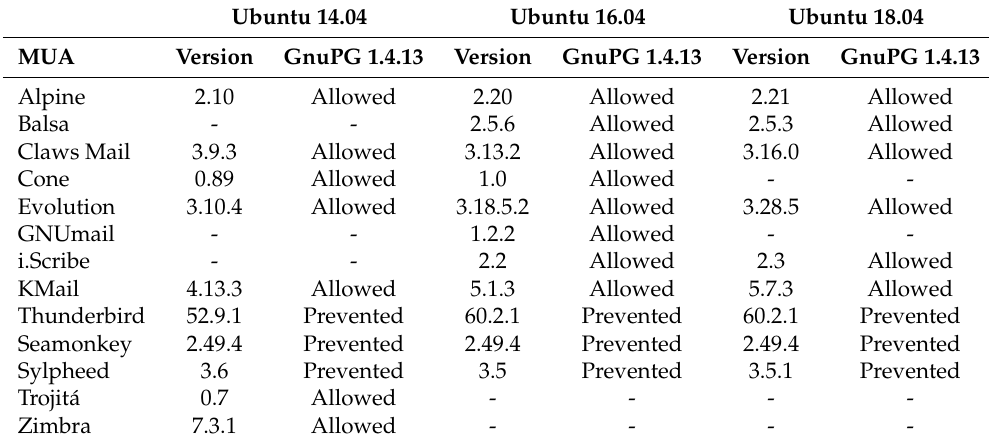
Table 1. Vulnerability Analysis of mail user agents